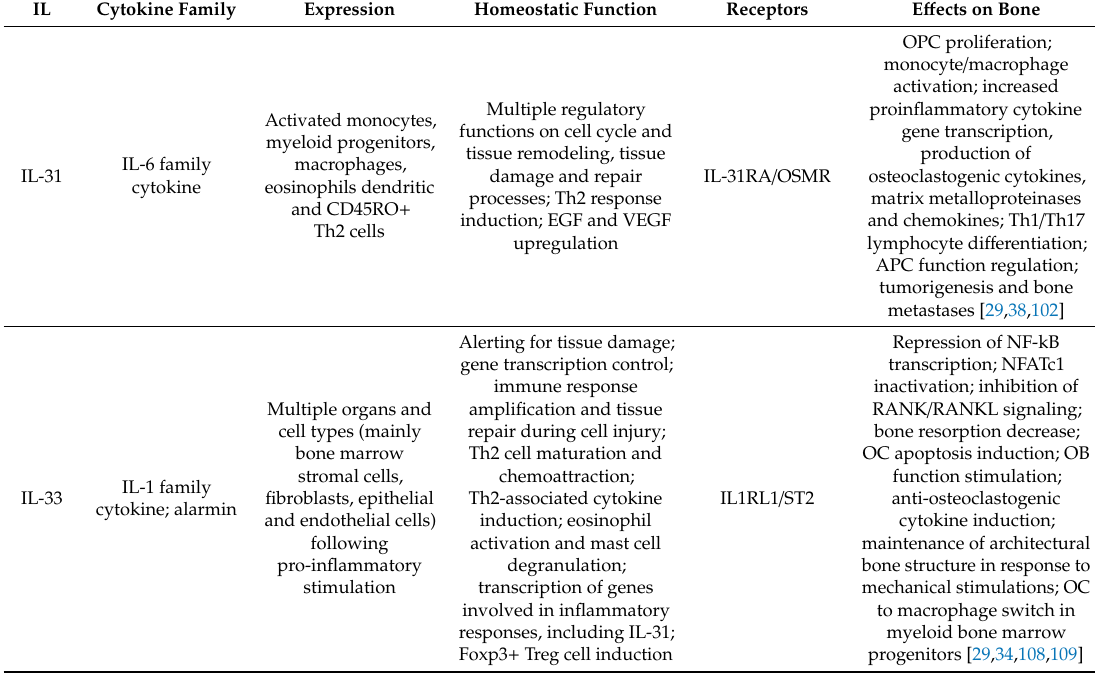
Table 1. Summary of IL-31 and IL-33 functions in